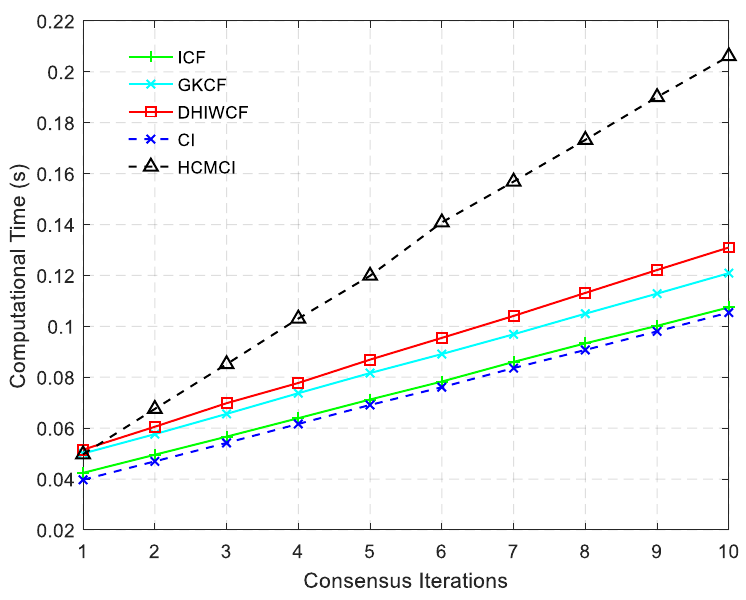
Figure 7. Computational cost of different algorithms.